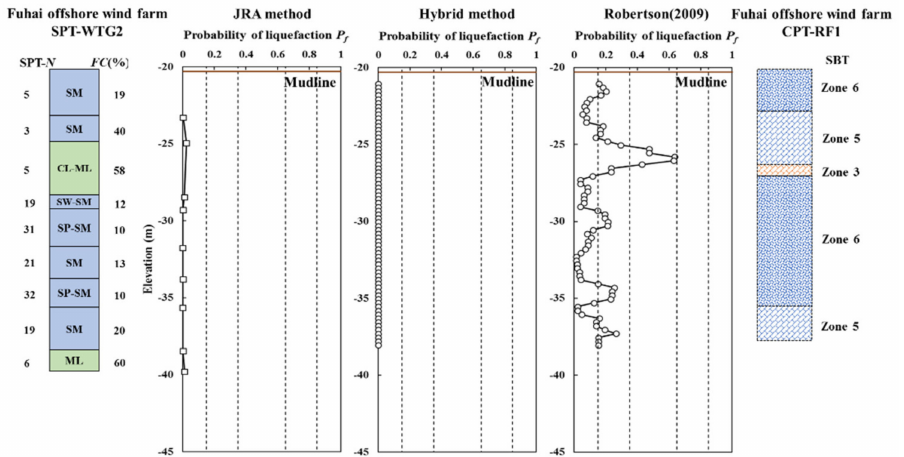
Figure 17. The probability of liquefaction of boreholes CPT-RF1 and SPT-WTG2 in Fuhai offshore wind farm.